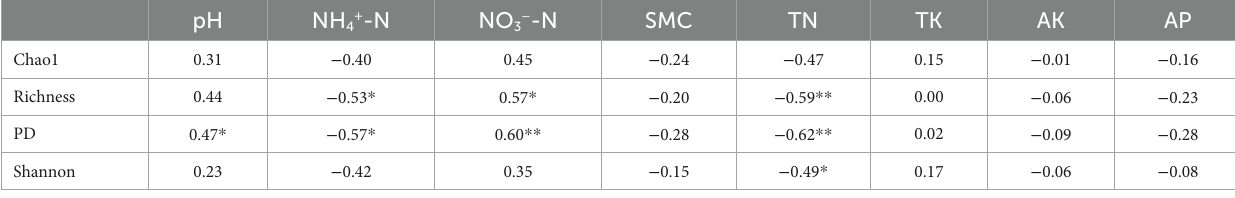
TABLE 3 Pearson’s rank correlation coefficients between fungal alpha-diversity and soil physicochemical characteristics.